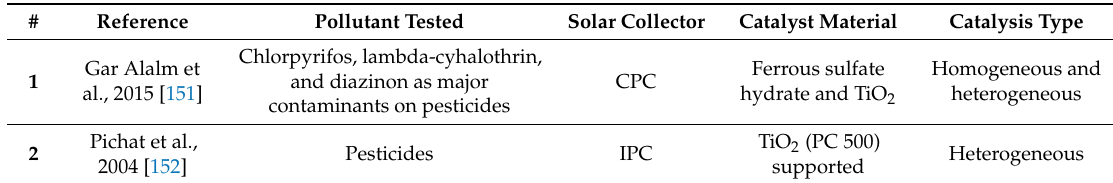
Table 10. Real wastewaters (Pesticides).